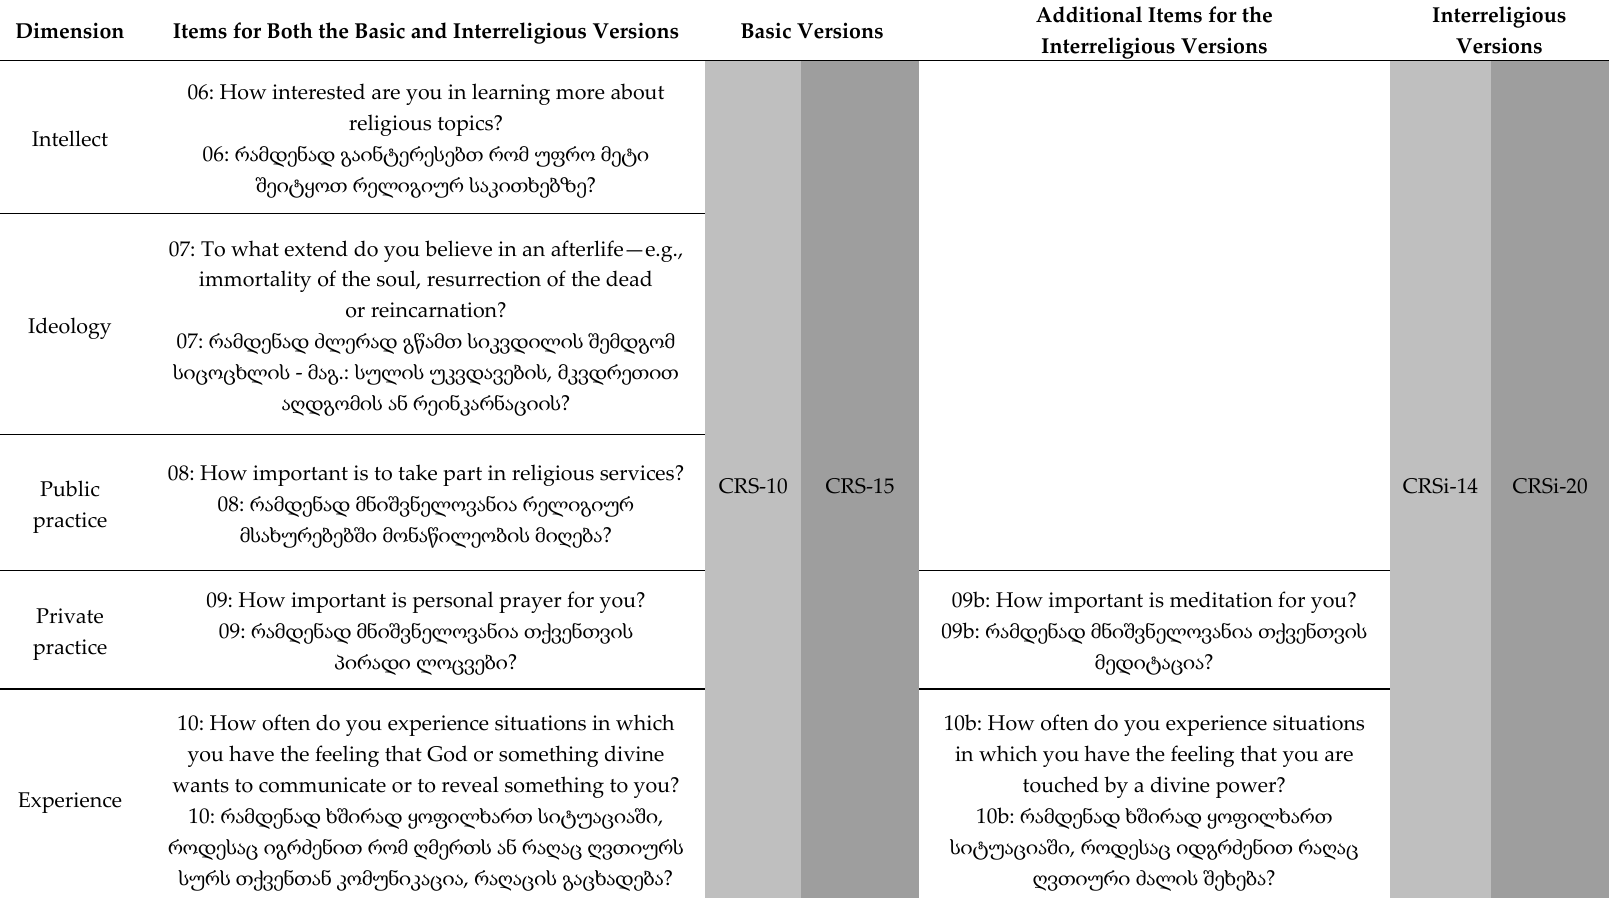
Table A2. Items of the CRS shared by the intermediate and long versions.